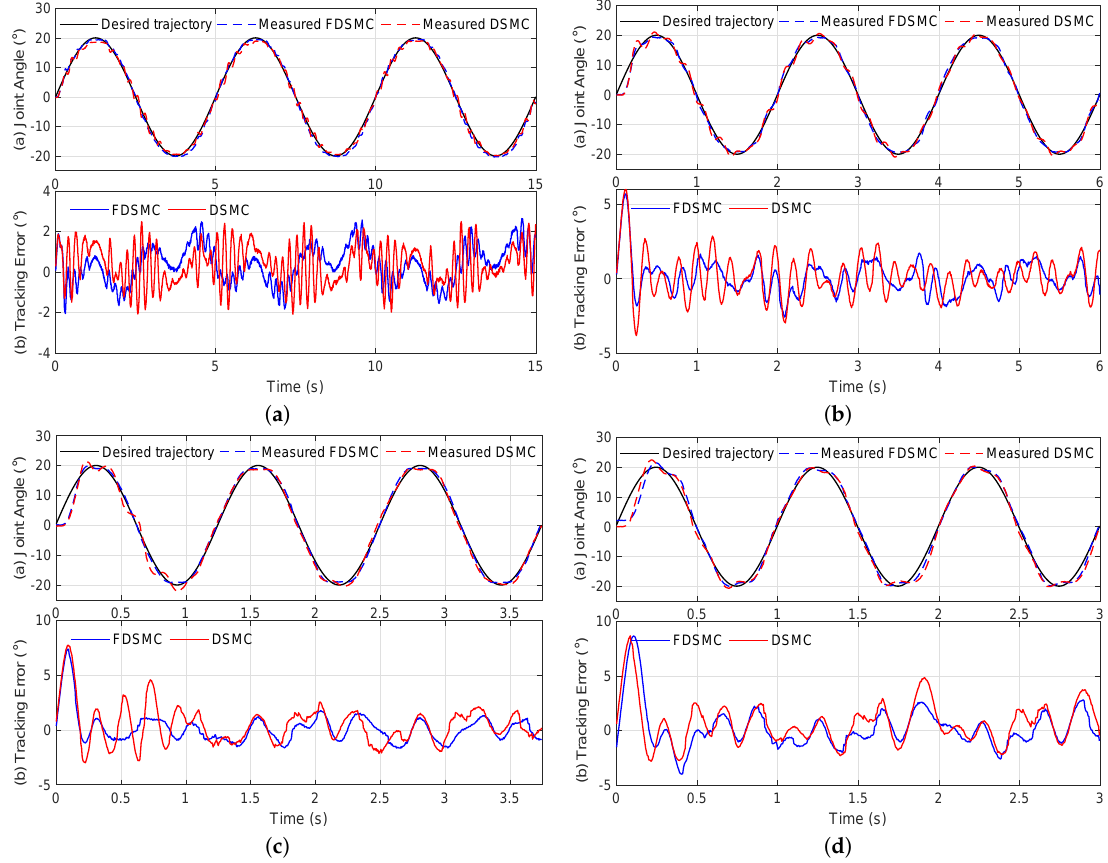
Figure 4. Experiment results without a load for tracking a sinusoidal trajectory: ( a ) 0.2 Hz, ( b ) 0.5 Hz, ( c ) 0.8 Hz, and ( d ) 1.0 Hz of signal